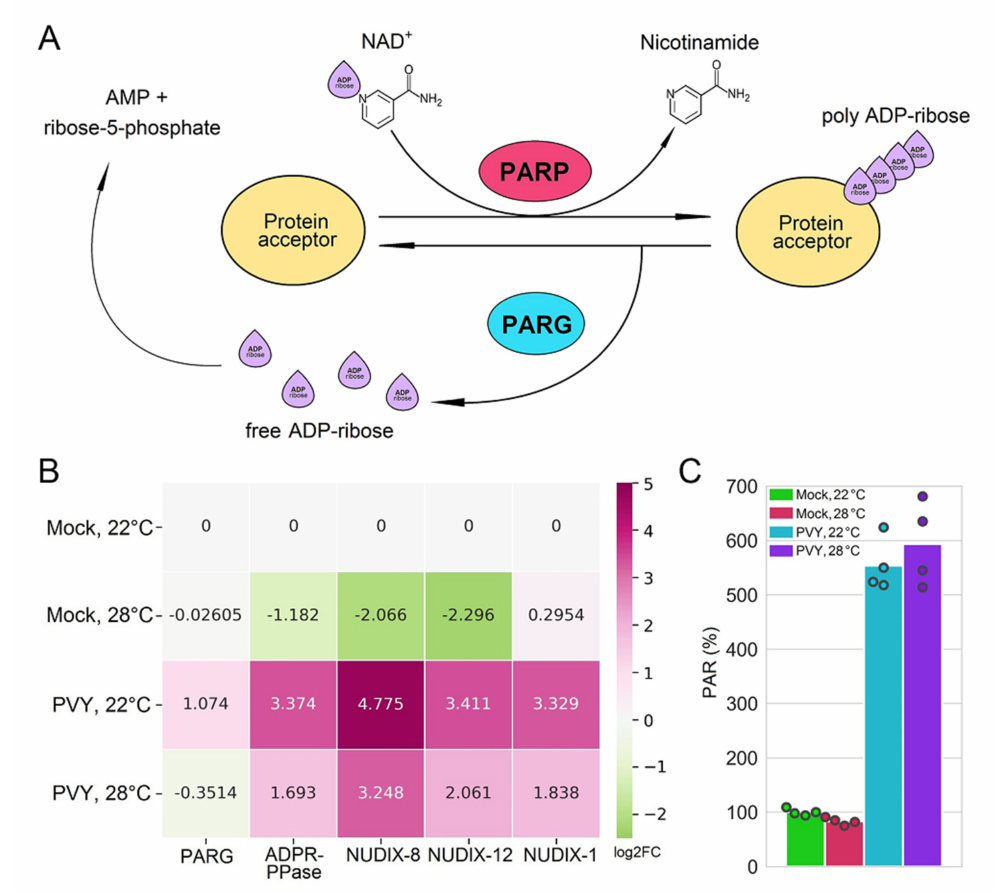
Figure 5. Poly (ADP-ribose) metabolism and susceptibility of Chicago plants to PVY. ( A ) Schematic representation PARylation process in healthy